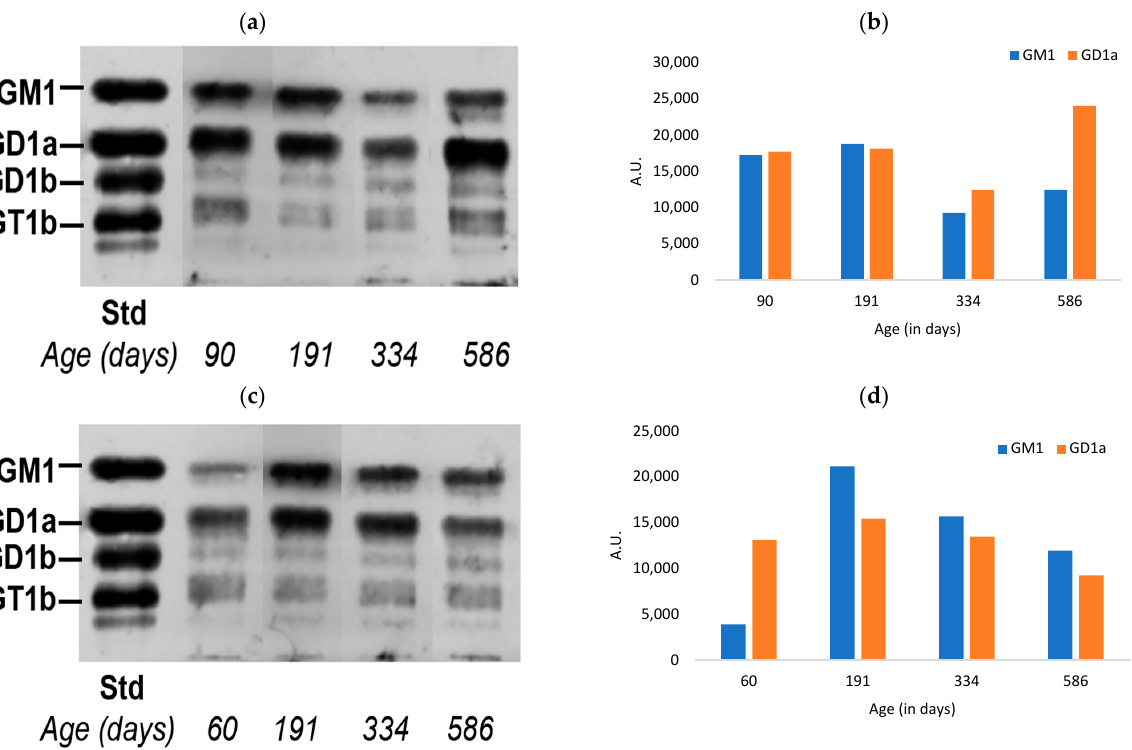
Figure 3. Quantification of a ‐ series gangliosides in the heart tissue of aging mice: ( a ) HPTLC of male mice heart tissue for the detection of gangliosides; ( b ) relative quantitation of the intensity of gangliosides; ( c ) HPTLC of female mice heart tissue for the detection of GM1 and GD1a; ( d ) relative quantitation of the intensity of GM1 and GD1a (A.U. = arbitrary units).